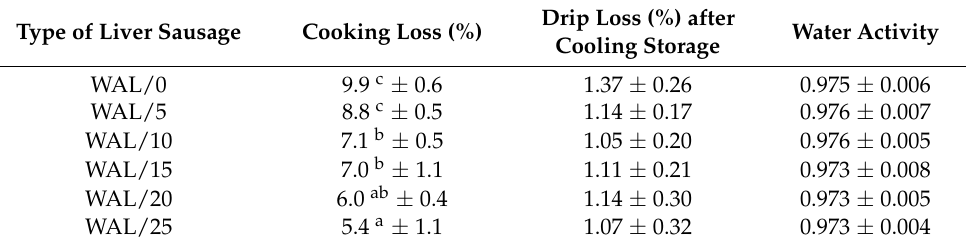
Table 1. The cooking loss, drip loss after cool storage, and water activity of the liver sausages (mean value ± standard deviation), n =